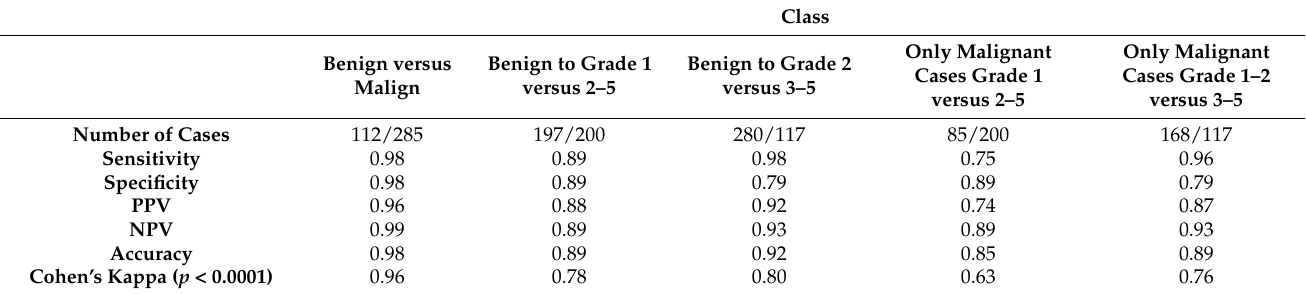
ted against the pathologist’s diagnosis of GGs and showed a logical shift of AI-diagnosed grade patterns that correlated with the pathologist’s diagnoses (Figure